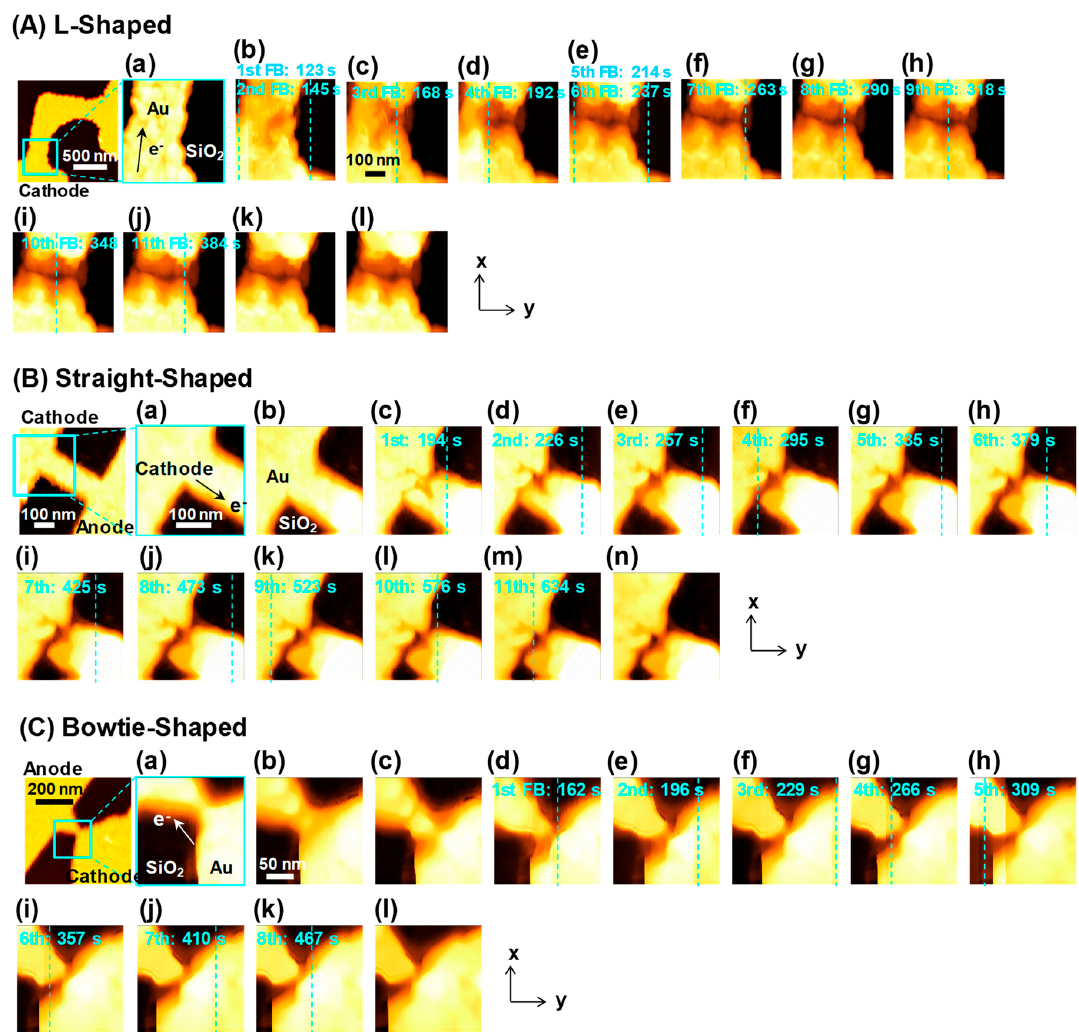
Figure 2. ( A ) Atomic force microscopy (AFM) images of the L-shaped nanowires captured with a scanning window of 500 × 500 nm 2 . The images were captured during the following time